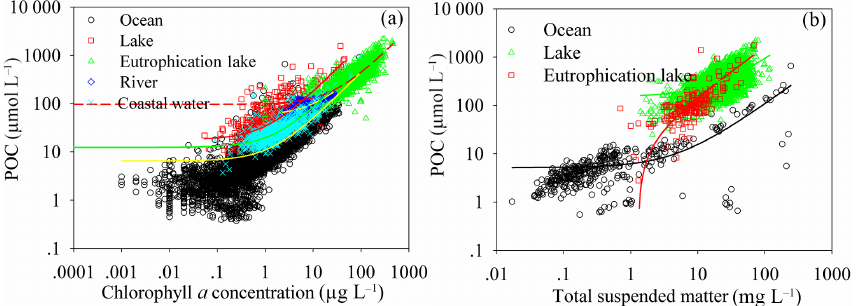
Figure 11. (a) Comparison of the relationships between POC and chlorophyll a concentration (C Chl a ) for oceans, lakes, eutrophic lakes, rivers and coastal waters. (b) Comparison of the relationship between POC and total suspended matter concentration (C TSM ) for oceans, lakes and eutrophic lakes. The relationships between POC and C Chl a are POC = 4 . 429 · C Chl a + 6 . 531 ( R 2 = 0 . 51, N = 5462, yellow solid line); POC = 16 . 420 · C Chl a + 17 . 855 ( R 2 = 0 . 64, N = 984, red solid line); POC = 3 . 513 · C Chl a + 96 . 528 ( R 2 = 0 . 72, N = 4656, red dashed line); POC = 4 . 458 · C Chl a + 55 . 931 ( R 2 = 0 . 77 , N = 936, yellow dashed line); and POC = 7 . 357 · C Chl a + 12 . 349 ( R 2 = 0 . 82, N = 692, green solid line) for oceans, lakes, eutrophic lakes, rivers, and coastal waters, respectively. The relationships between POC and C TSM are POC = 1 . 045 · C TSM + 5 . 198 ( R 2 = 0 . 53, N = 432, black solid line); POC = 15 . 932 · C TSM − 25 . 645 ( R 2 = 0 . 67, N = 191, green solid line); and POC = 7 . 984 · C TSM + 149 . 950 ( R 2 = 0 . 27, N = 4683, red solid line) for oceans, lakes, and eutrophic lakes, respectively.